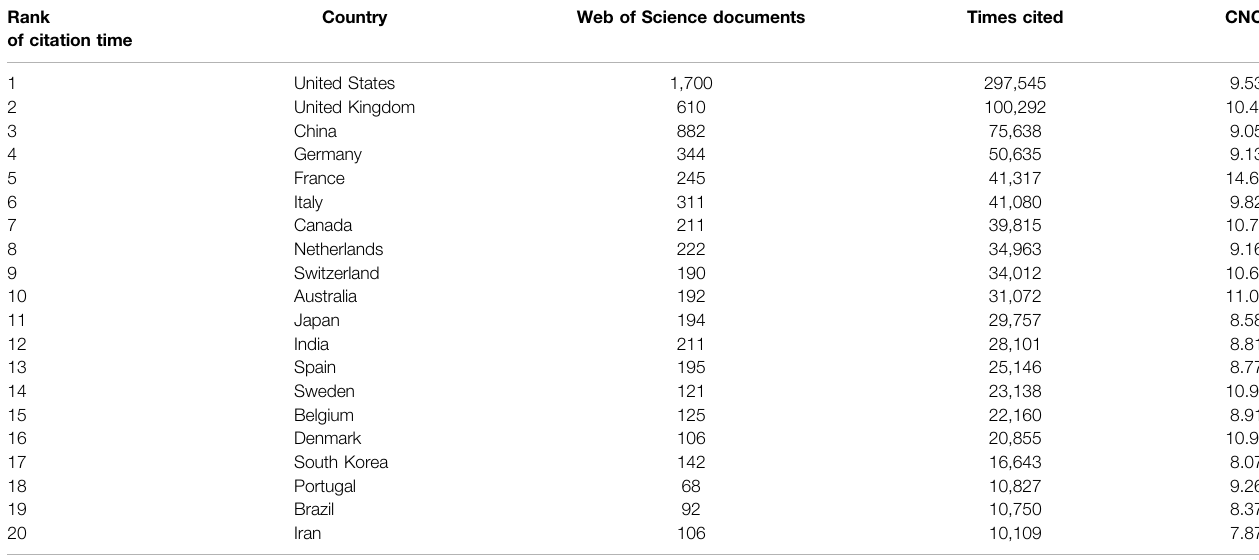
TABLE 3 | Number of high-impact papers in pharmacology and pharmacy and CNCI value by country. Rank of citation time